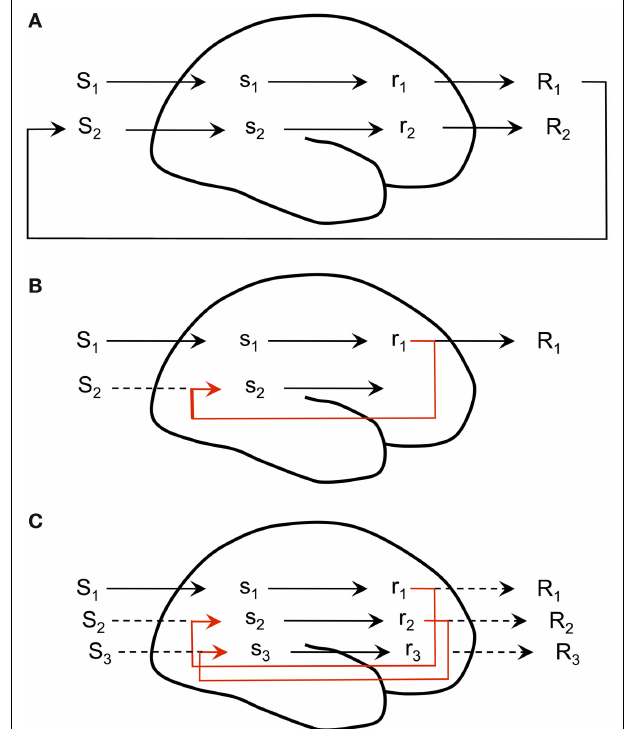
FIGURE 1 | Internal simulation . (A) stimulus S 1 elicits activity s 1 in the sensory cortex. This leads to the preparation of a motor command r 1 and an overt response R 1 . This alters the external situation, leading to S 2 , which causes new perceptual activity, and so on. There is no internal simulation. (B) The motor command r 1 causes the internal simulation of an associated perception of, for example, the consequence of executing that motor command. (C) The internally simulated perception elicits the preparation of a new motor command r 2 , i.e., a covert action, which in turn elicits the internal simulation of a new perception s 3 and a consequent covert action r 3 , and so on [redrawn from Hesslow